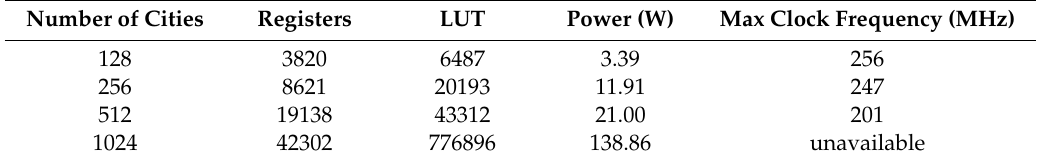
Table 2. Crossover module synthesis results on FPGA.